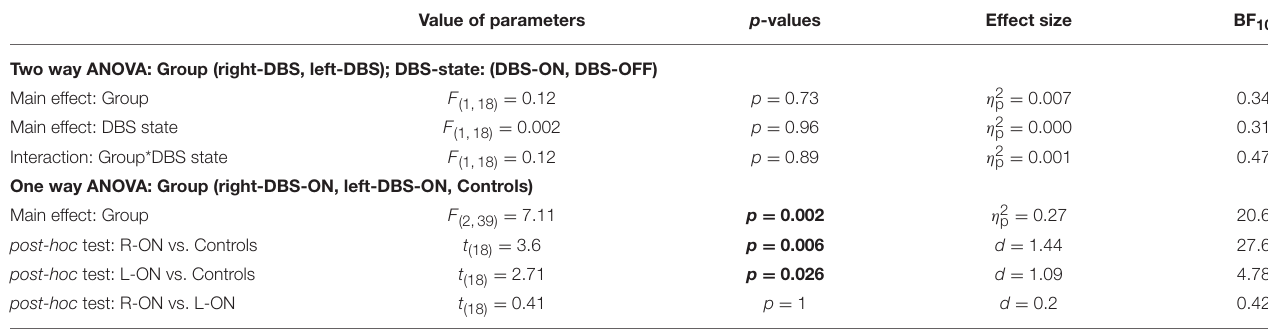
TABLE 4 | Results of the statistical analysis of the mean SSRTs across right-DBS patients, left-DBS patients, and age-matched controls. Value of parameters p -values Effect size BF